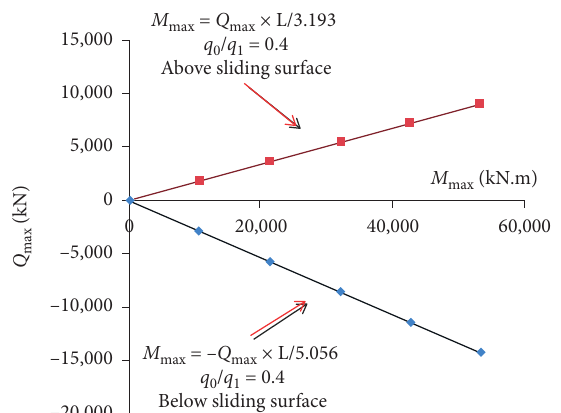
Figure 10: Calculation results of the maximum bending moment and the maximum shear forces above or below the slip surface of the pile under different driving